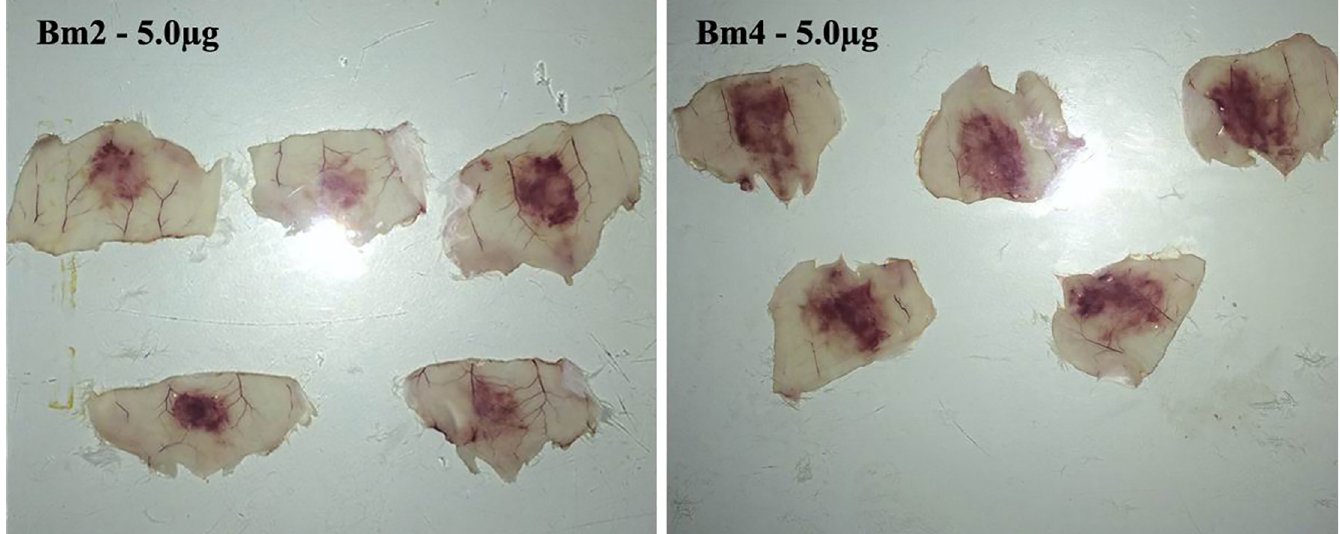
Fig 9. Hemorrhagic activity of two individual venoms of B . moojeni snakes. The hemorrhagic halos were the result of the intradermal injection of 5 μ g of B . moojeni venom belonging to specimens Bm2 (A) and Bm4 (B).